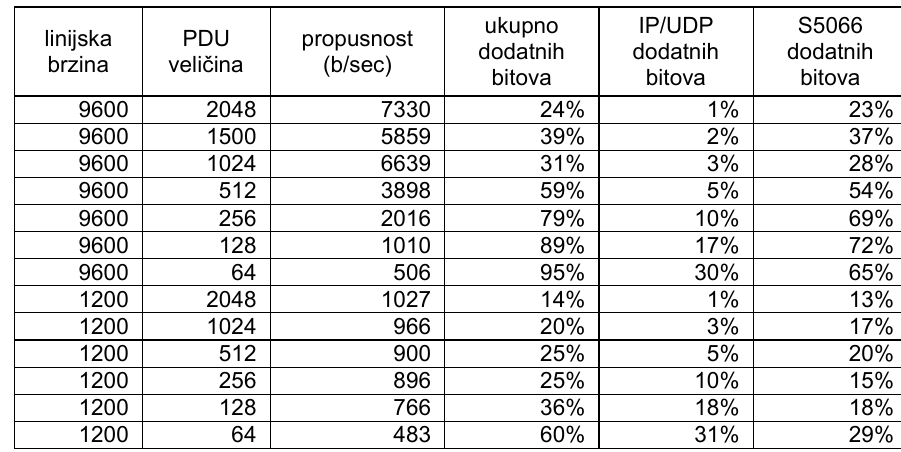
Table 4 – UDP protocol throughput with STANAG